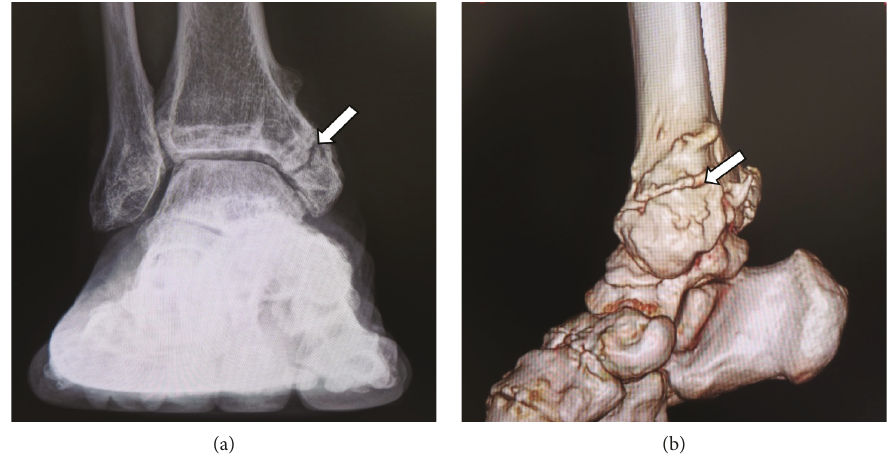
Figure 1: (a) Plain radiography and (b) 3-dimensional computed tomography image indicating nonunion of the medial malleolus. Arrow shows nonunion site of the medial